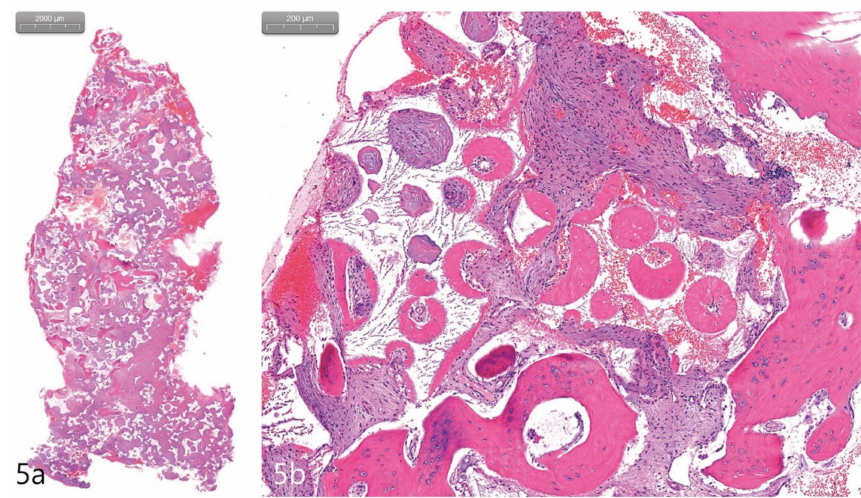
Figure 5. ( a ). The core biopsy with H&E stain. ( b ). The newly generated bone was well-observed around the bone substitute particle. The new bone contained osteoids, osteoblasts, and osteocytes. Immature osteoid tissue was distributed between bone grafts (H&E stain).